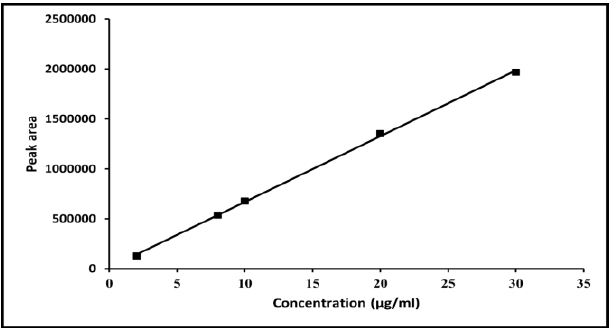
Fig. 4 . Calibration curve for determination of CHX in pure form at λ max = 260 nm using the proposed